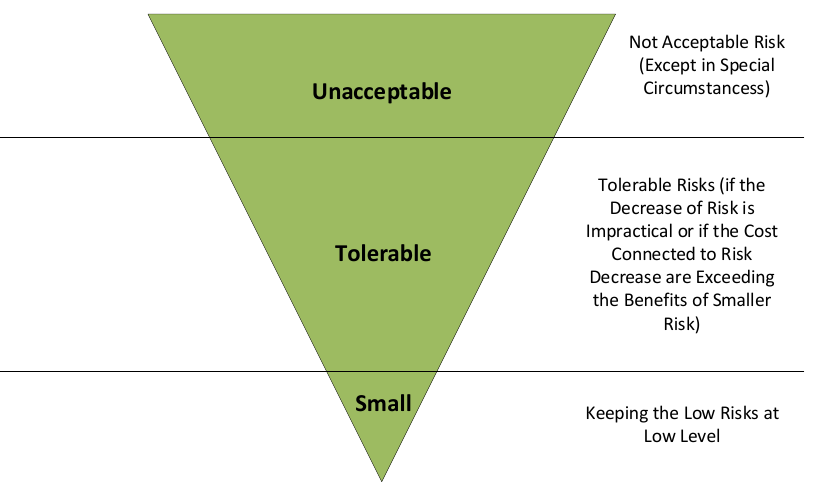
Figure 14. Basing the risk criteria of zones of acceptable low risk, tolerable risk and unacceptable